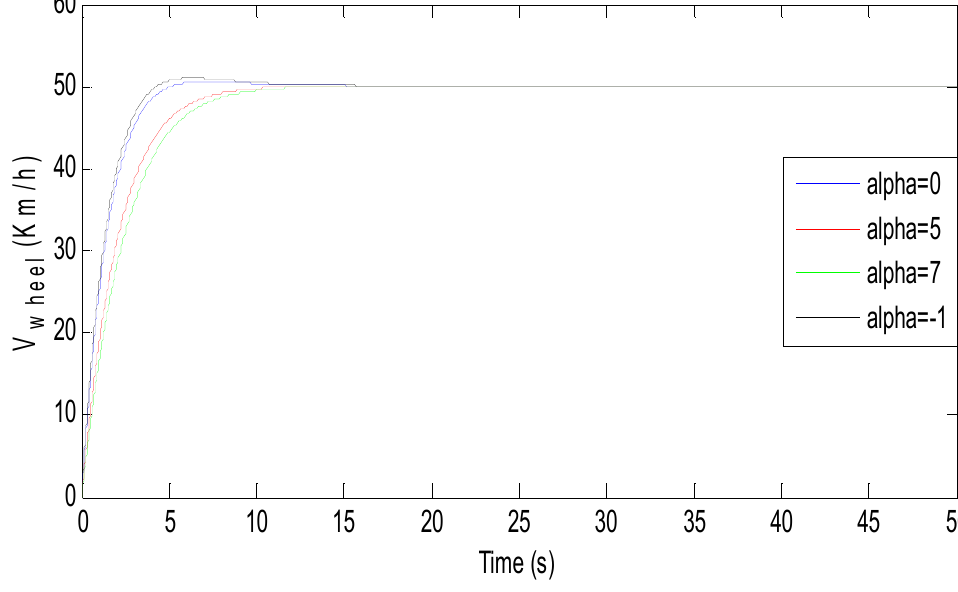
Figure 38. Wind variation effect of surface-friction coefficient on BEV speed response. From Figure 39 one can deduce that when wind speed is in the same direction as BEV motion, its response becomes faster and this increases the performance of its speed re- sponse in terms of rising and settling time. However, when wind speed is against vehicle motion, the overshoot of the speed response gets lowered and its dynamics becomes rel- atively slow. Figure 40 confirms that BEV performances gets slow as road slope increases and the inverse is correct. Figure 41 confirms that road type does affect BEV speed re- sponse.